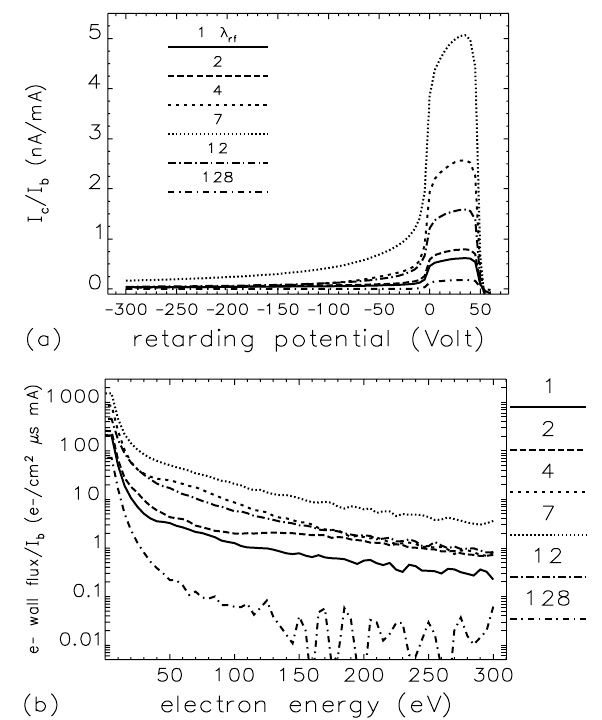
FIG. 8. (a) Normalized collector current versus retarding potential, e (cid:6) beam, 20 mA, ten bunches, as a function of (cid:1) 2 : 84 ns . (b) Electron energy bunch spacing, in units of (cid:2) rf distributions obtained by differentiating the data in (a). The data show that the cloud has the longest energy tail at the ). The beam-induced multipacting bunch spacing of 20 ns (7 (cid:2) rf spacing case) low-energy parts of the distributions (and 128 (cid:2) rf are well fitted by a Lorentzian function of width 4 eVand mean energy 2.5 eV. The high-energy part is